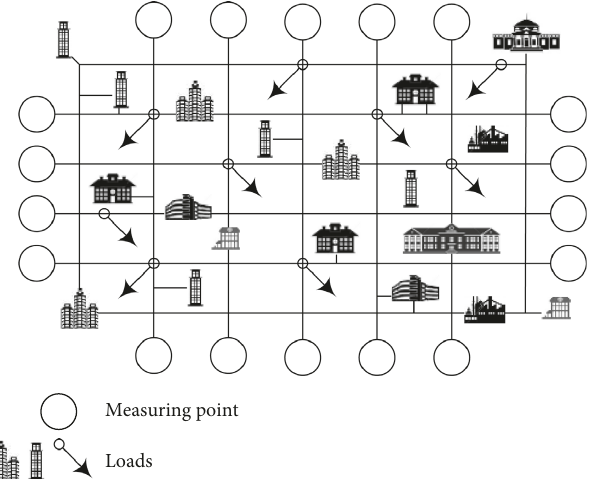
Figure 2: Schematic diagram of the secondary network in Figure